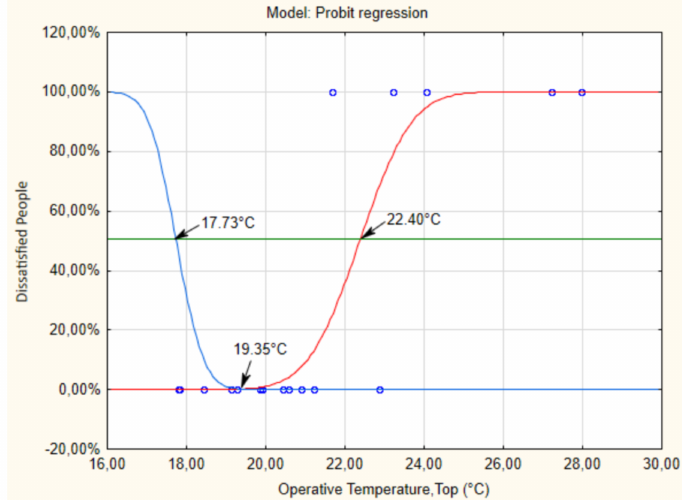
Figure 10. Probit